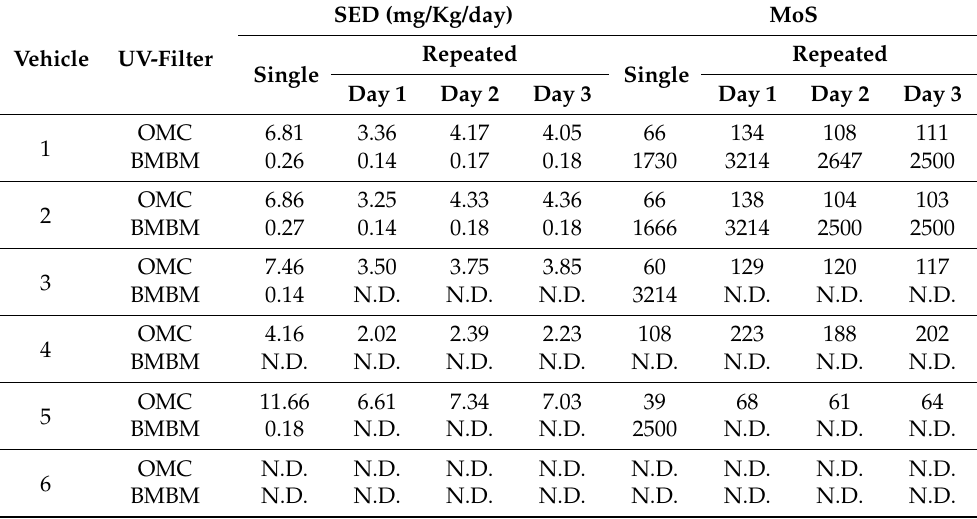
Table 9. SED and MoS values of OMC and BMBM determined after a single application (single) or repeated applications (repeated) for three consecutive days of vehicles 1–6. N.D. = Not